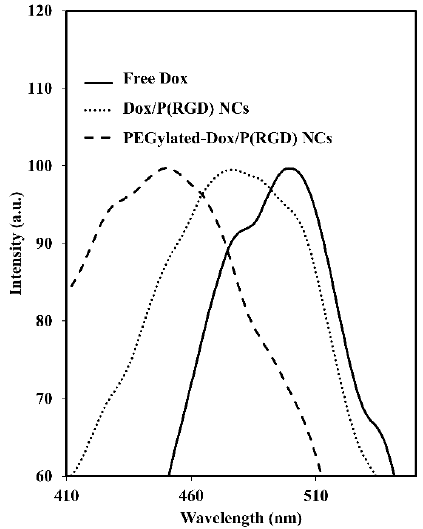
Figure 4. Excitation curves of free Dox (solid line) and non-PEGylated (dotted line) and PEGylated (dashed line) Dox/P(RGD) NCs.